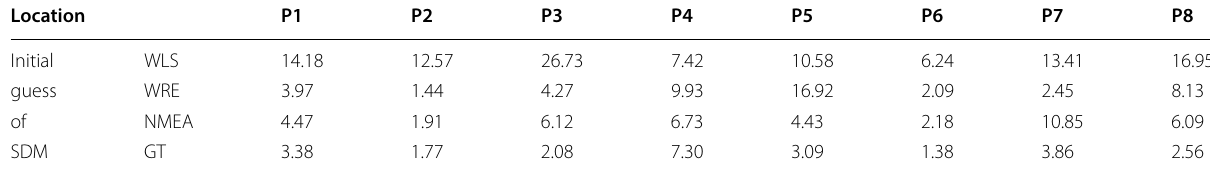
Table 8 The across error of SVM classification based shadow matching initialized by different approaches (m)